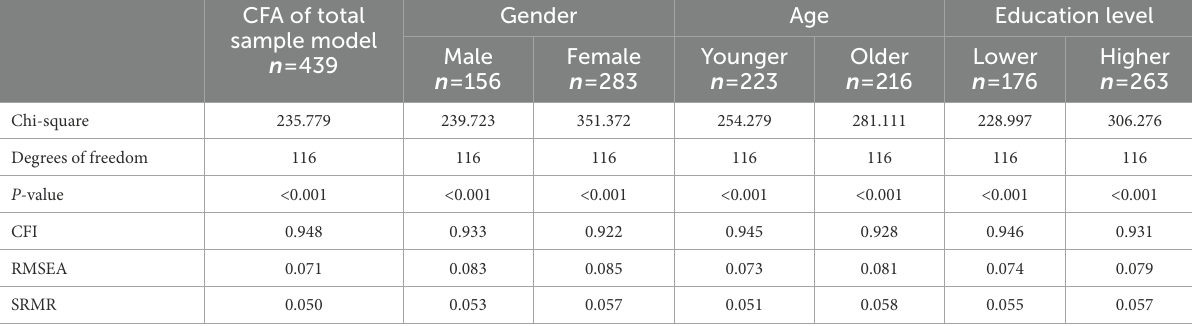
TABLE 4 Factorial validation in subsamples categorized by gender, age, and education